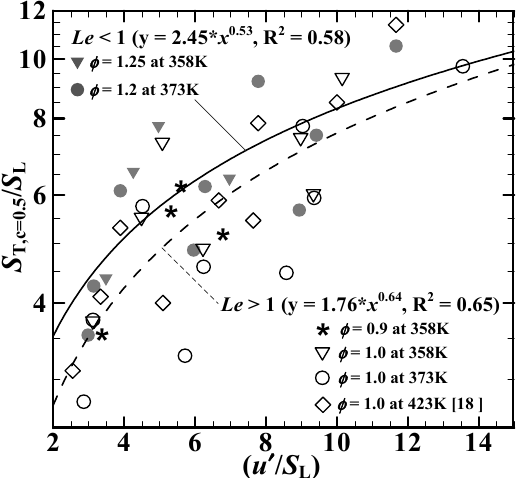
Figure 5. Normalized turbulent burning velocities at 𝑐̅ = 0.5 plotted against turbulent intensities ( u ′ /SL) at different pressure p = 0.5–3 atm at 373 K and p = 1–5 atm at 358 K and/or 423 K.